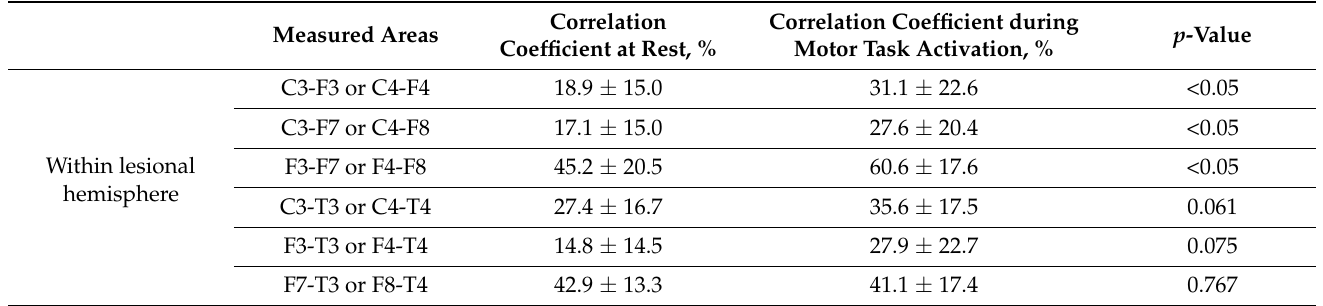
Table 2. Changes in correlation coefficient with motor task